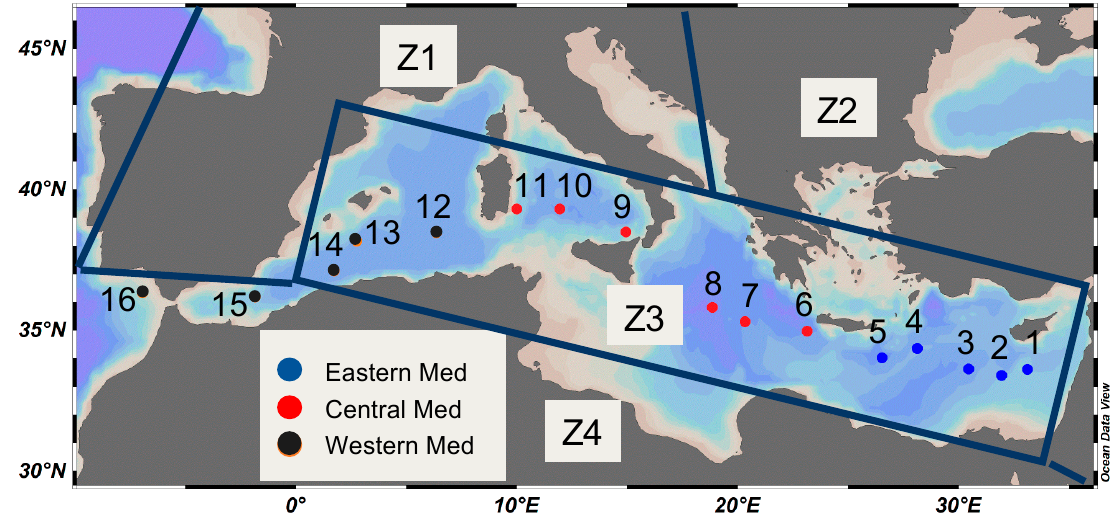
Figure 1. Map of the sites where aerosols were collected throughout the Mediterranean Sea (MS) in April on the R/V METEOR cruise M84/3, with sample IDs, region of collection (eastern Med = blue, central Med = red, and western Med = black), and airmass origin zones (Z1 – Z4) shown.